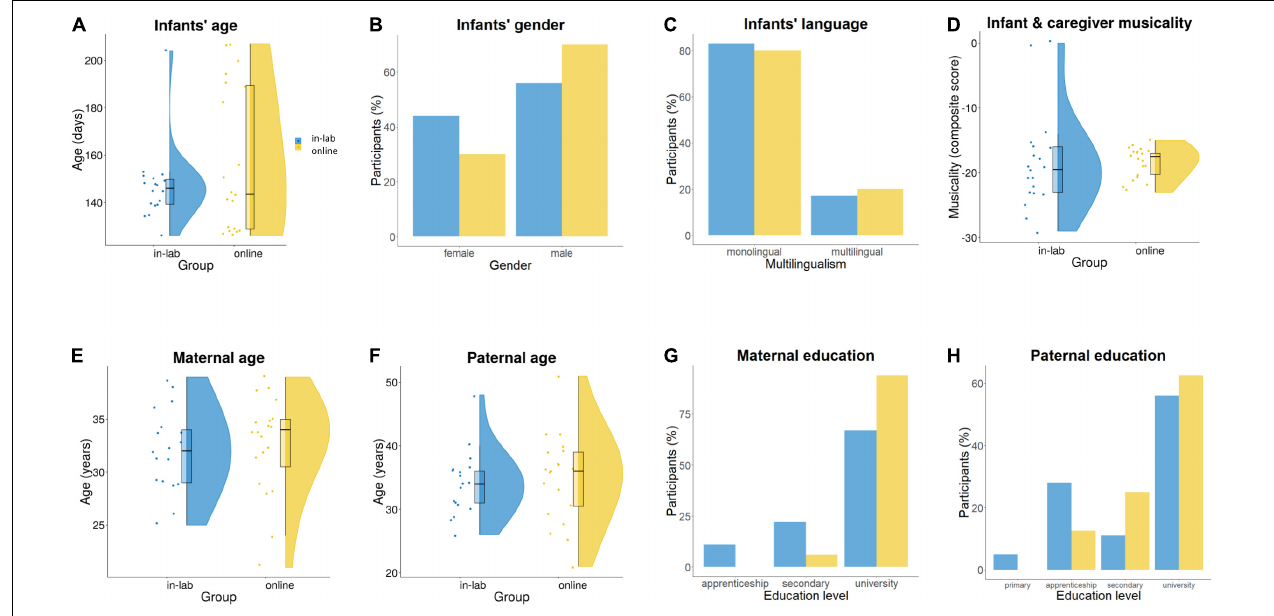
FIGURE 3 | Demographic comparison of the in-lab and online samples with regard to panel (A) infants’ age; (B) infants’ gender; (C) infants’ language (multilingualism); (D) infants’ and caregivers’ musicality; (E) maternal age; (F) paternal age; (G) maternal education; and (H) paternal education.